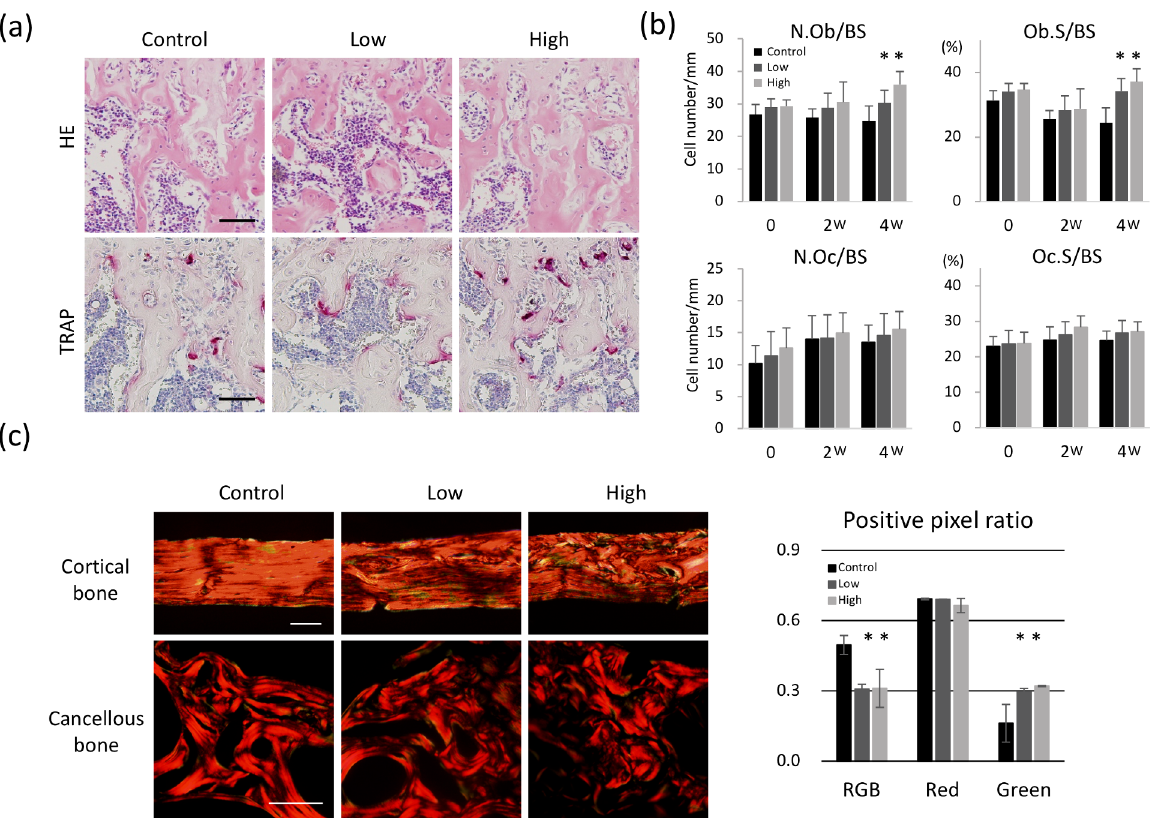
Fig 5. Histological and histomorphometric analysis. (a) Hematoxylin and eosin, and tartrate-resistant acid phosphatase (TRAP)-stained histological sections of the distal femur epiphysis at 0 week (after 8-week of the BAPN consumption). (b) No differences of osteoblast and osteoclasts activities were observed at 0 and 2 weeks after replacing to the control diet. After 4 weeks, number of osteoblasts per bone surface (N. Ob/BS) and osteoblast surface per bone surface (Ob.S/BS), representing osteoblast activity, significantly increased, while number of osteoclasts per bone surface (N.Oc/BS) and osteoclast surface per bone surface (Oc.S/BS), representing osteoclast activity did not change. (cid:3) p < 0.05, compared to the control. Bar: 50 μ m. (c) Picrosirius red-stained samples at 16 weeks of age (after 8-week of the BAPN consumption followed by 4-week of control diet) are analyzed under polarized light. After 4-week of control diet, immature/irregular collagen matrix still detected both in cortical and cancellous bone. Bar: 50 μ m. Quantitative data also confirmed that the immature collagens, detected in green, retained high value after 4-week of control diet in cancellous